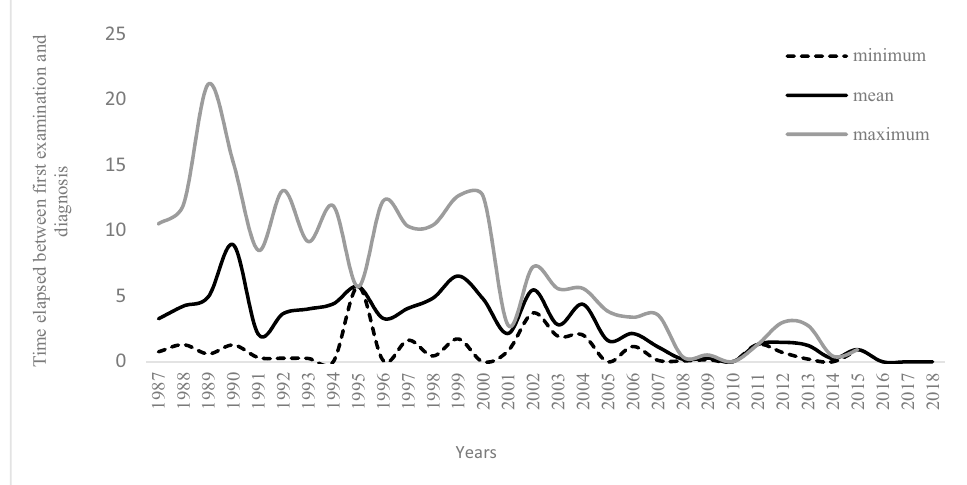
Figure 1. Time in years for disease outcome in the contacts cohort, according to year of the first examination. Cohort of contacts at the FIOCRUZ clinic, 1987–2018. Dotted line-minimum; black mean; gray-maximum.